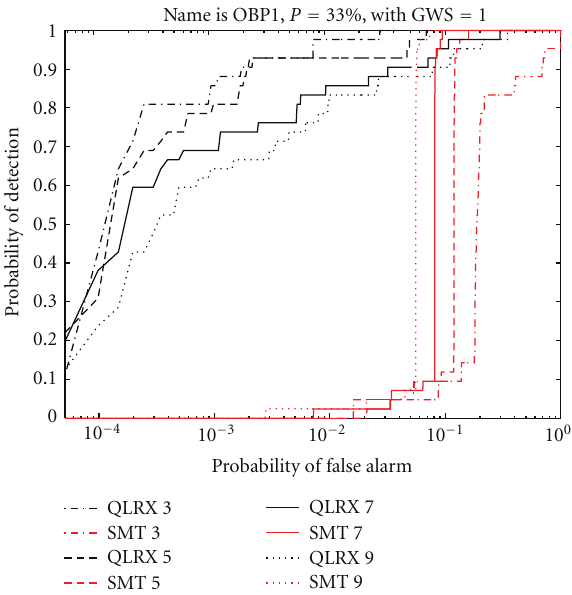
Figure 4: OBP1 results with OWS given by the number in the